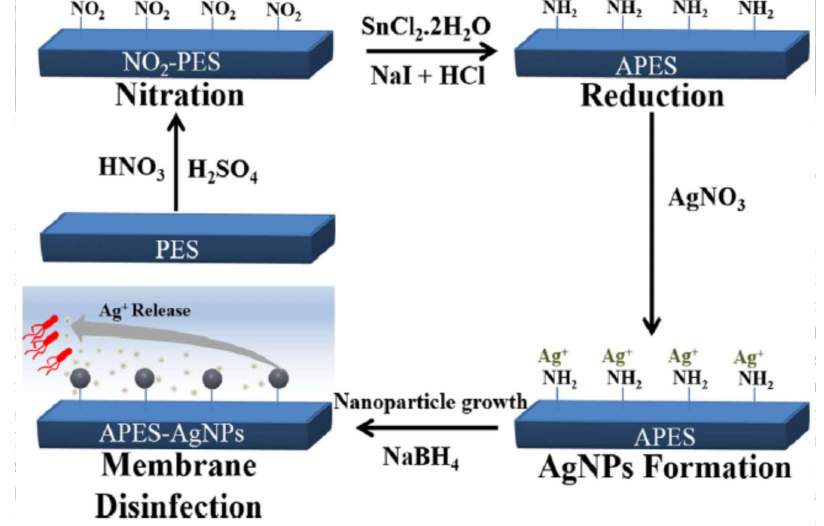
Figure 7. Schematic illustration of aminated-polyethersulfone (APES) membranes decorated with AgNPs, adapted from Aider et al.